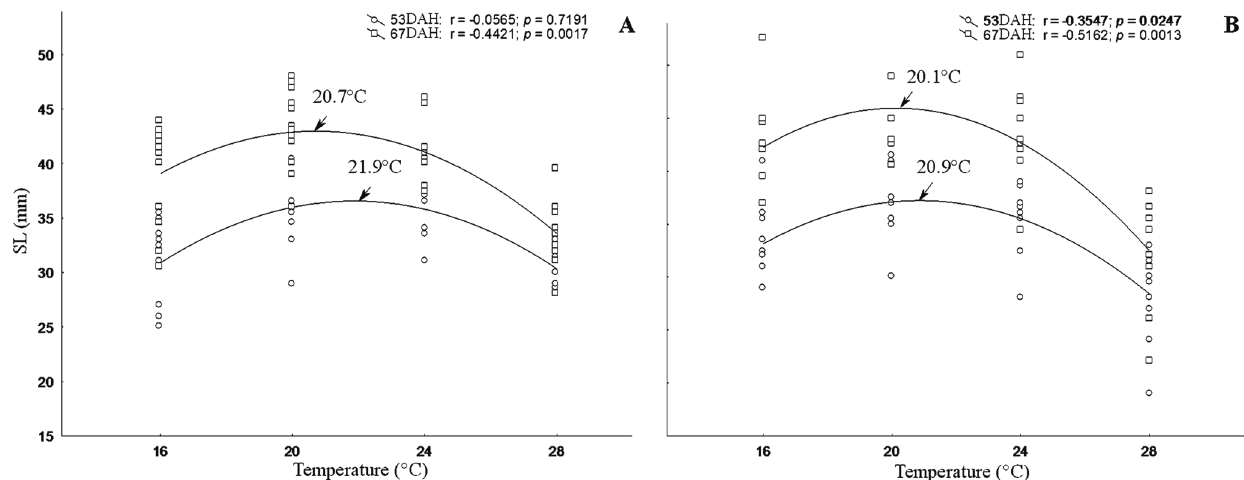
Fig. 5. Effect of temperature on growth in standard length (SL) of female (A) and male (B) of Austrolebias wolterstorffi under different ages (DAH = days after hatching). The arrows indicate the inflection points of